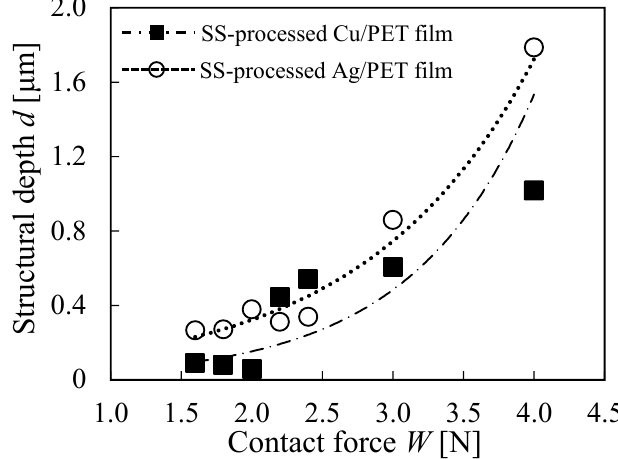
Figure 5. Contact force dependence of the structural period for the SS-processed metal/PET films. Processing conditions: T = 3.09–7.73 N, θ = 150.0°, V = 10.0 mm/min, and L = 1.0 mm.